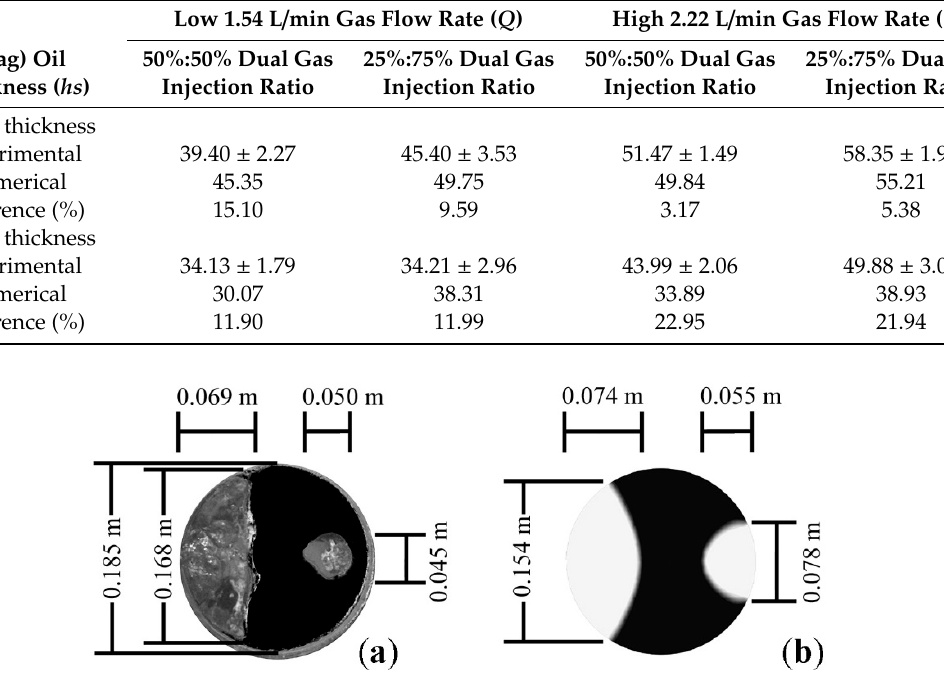
Figure 8. Comparison of the time-averaged photograph of the slag eye obtained with the ( a ) Figure8. Comparisonofthetime-averagedphotographoftheslageyeobtainedwiththe( a )experimental experimental model (operating condition of differentiated dual gas injection with 5% (slag) oil model (operating condition of di ff erentiated dual gas injection with 5% (slag) oil thickness and 2.22 L / min thickness and 2.22 L/min gas flow rate) and the corresponding time-averaged ( b ) numerical model gas flow rate) and the corresponding time-averaged ( b ) numerical model prediction. Dimensions of prediction. Dimensions of measured and predicted open slag eyes are also indicated. measured and predicted open slag eyes are also Table 5. Slag eye area as a percentage of the total surface area for different operating conditions experimentally obtained through image analysis from both experimental and numerical models.